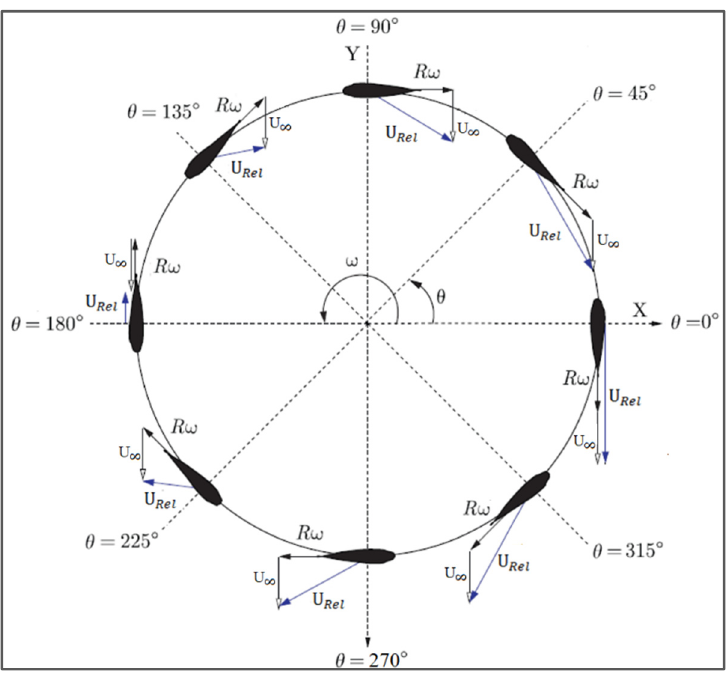
Figure 6. Velocity triangles for the spherical helical turbine in a gravity-fed system. U Rel is the resultant velocity which is the vector sum of free stream velocity of flow medium ( U ∞ ) and that is created from the free-stream ( U ∞ ) and rotational velocity ( R ω ). The resultant velocity U Rel can be illustrated from Equation (7).